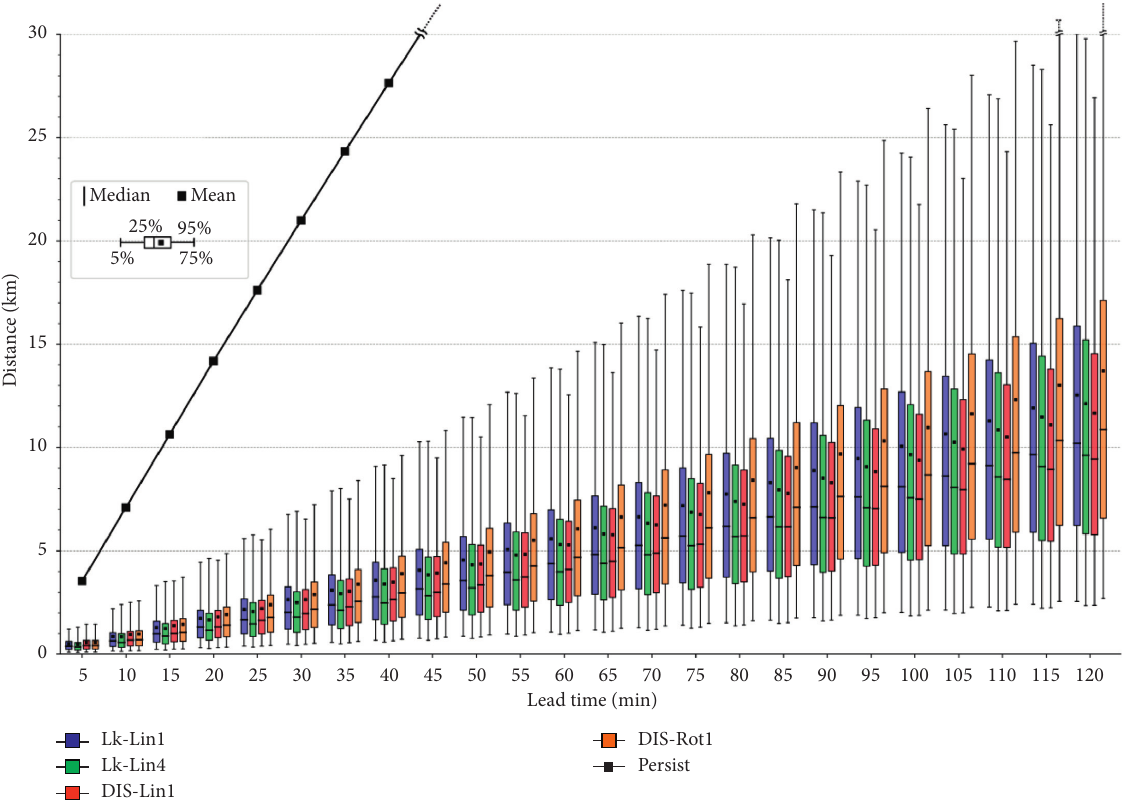
Figure 8: The distribution of location errors for different extrapolation models and lead